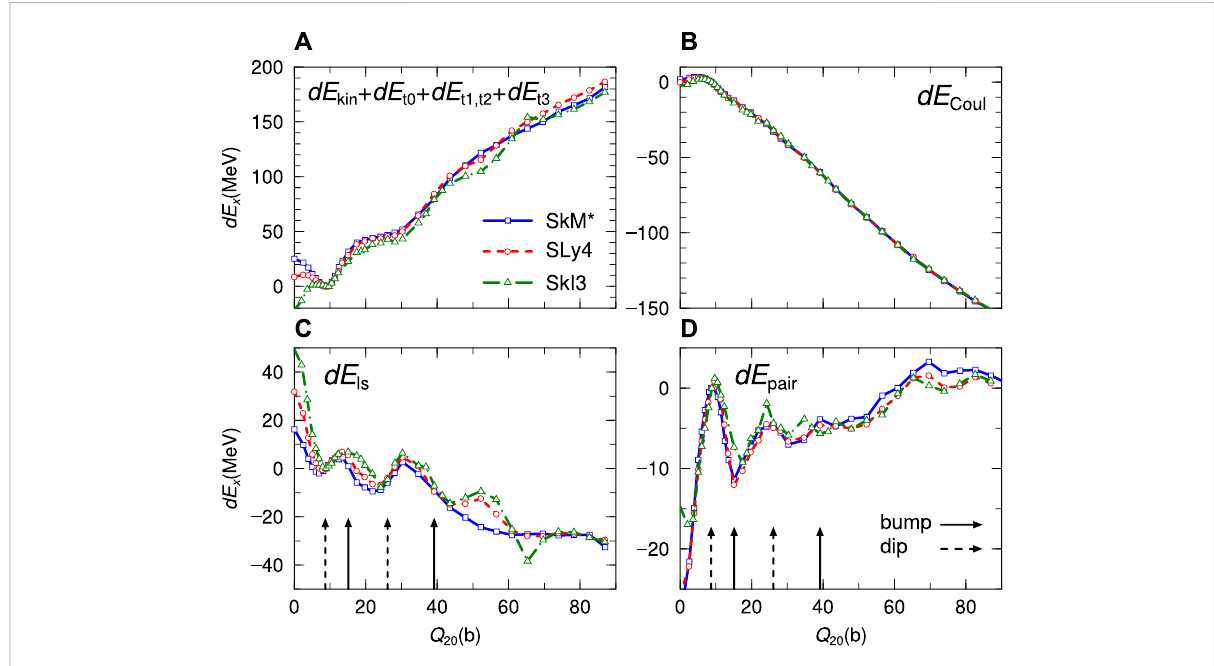
FIGURE 4 The dE x on the fi ssion path for the three EDFs (SkM*:solid, SLy4:dashed, SkI3:dashed-dotted) as functions of Q 20 . (A,B) show the results of dE x for dE kin + dE t0 + dE t1,t2 + dE t3 ,andfor dE Coul ,respectively. (C,D) showtheresultsof dE x for dE ls and dE pair .Thesolidanddashedarrowsinthebottom panels indicate the positions of bumps and dips of the fi ssion